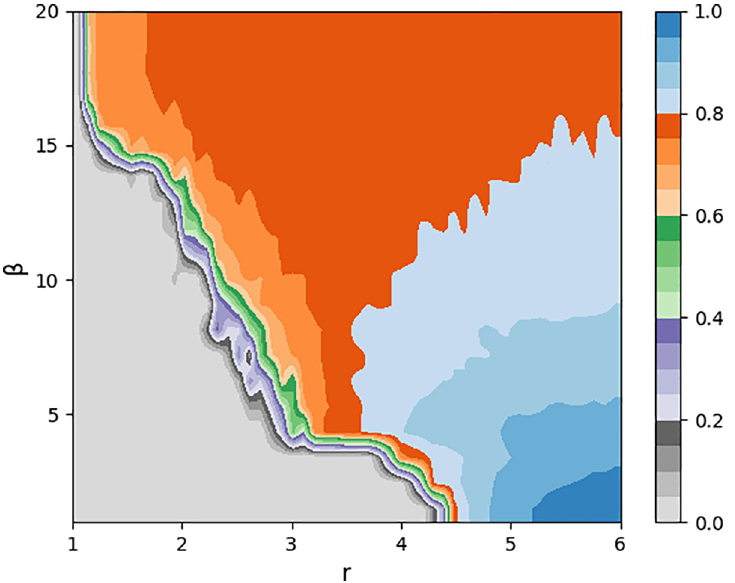
Fig 10. The effects of parameter β in partner switching Model-I , which is the average fraction of cooperators as a function of ( β , r ). When defection dominates ( r < 4), β increasing can promote the emergence of cooperation. When cooperation dominates ( r > 4), the increase of β will reduce the level of cooperation in the network. Parameters: N = 10000, t = 10000, T = 20, ^ k ¼ 4 , α = 5 and ω = 0.1.